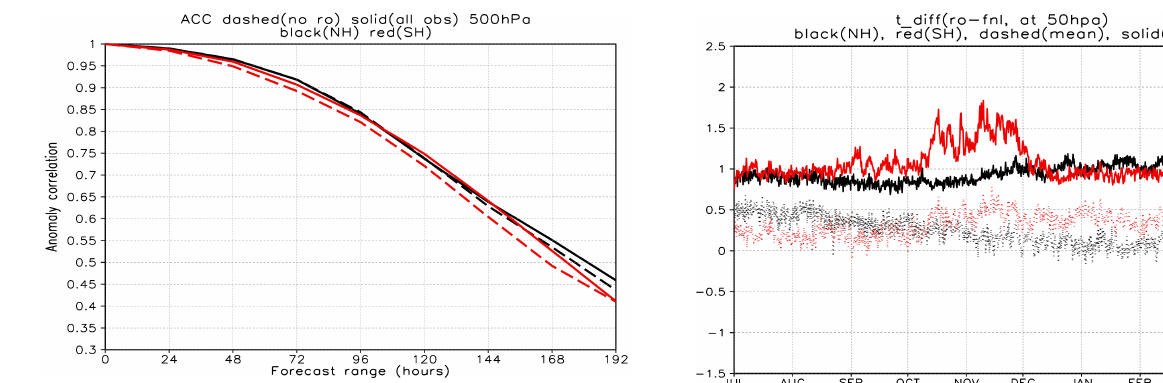
Figure 9. Mean (dashed line) and RMSE (solid line) of the 50hPa temperature analysis difference between GRAPES and NCEP (GRAPES minus NCEP) in a cycle running from 00:00UTC 1 July 2011 to 18:00UTC 16 April 2012. Black lines denote the results of the NH, and red lines denote the results of the